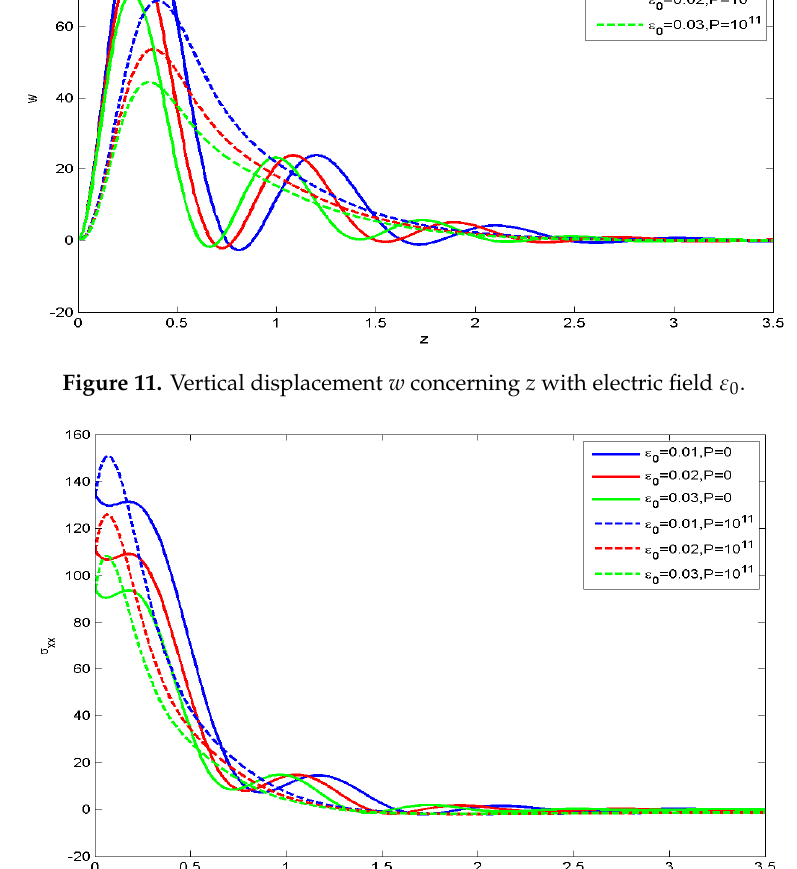
Figure 12. Normal stress σ xx concerning z with electric field ε 0 .